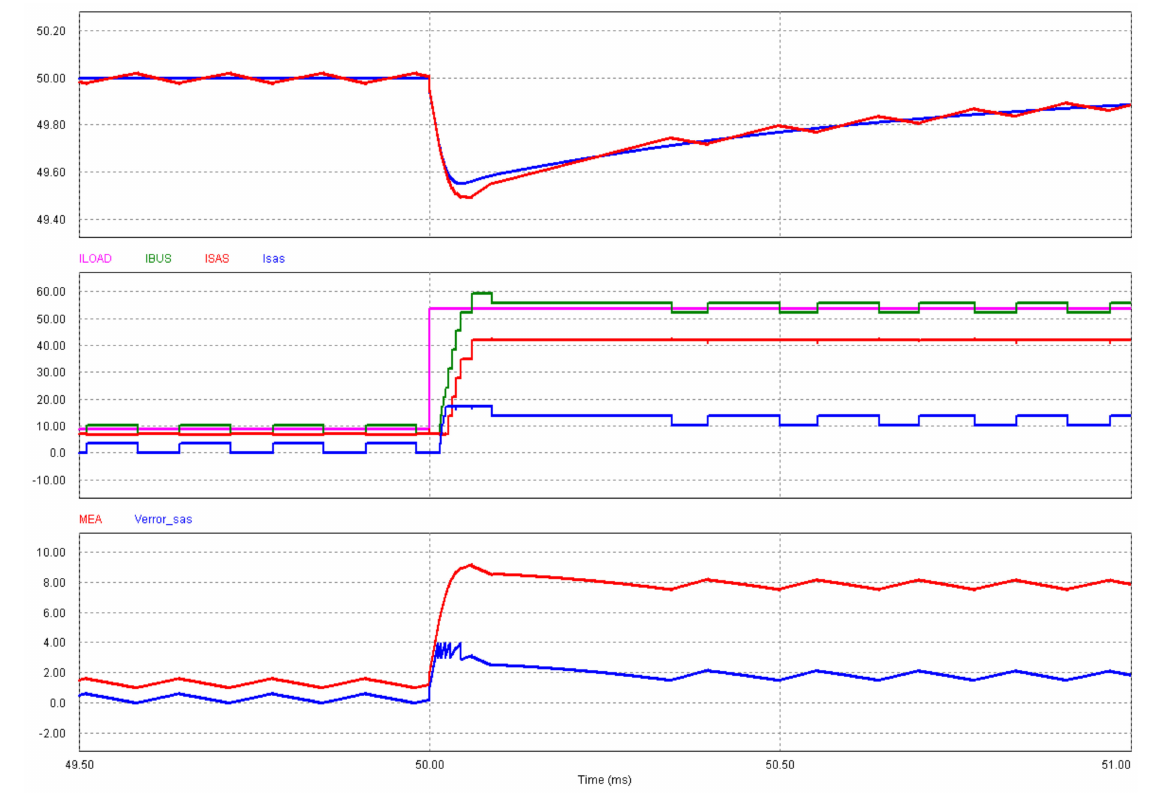
Figure 7. Simulation waveforms.